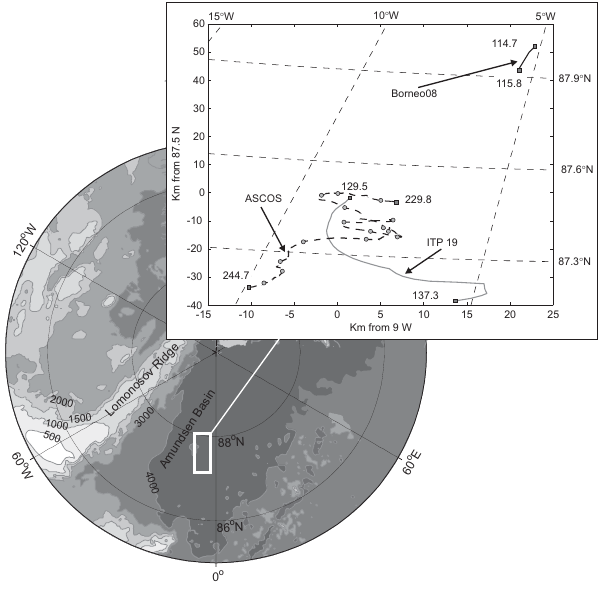
Fig. 1. The drift trajectory of the ASCOS field experiment, the Borneo08 experiment and the ITP19 drifting buoy. The map with bathymetric depth contours outlined, shows the study region loca-